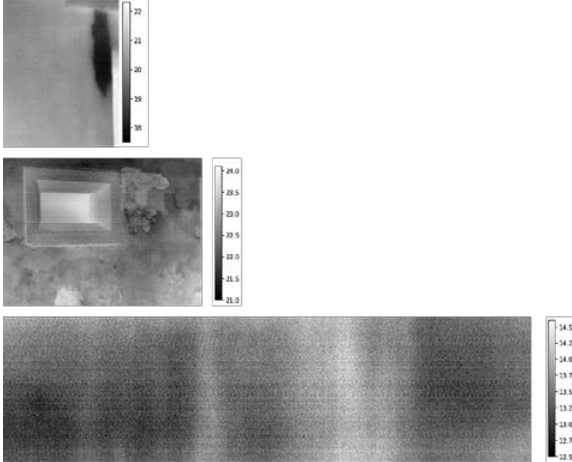
Figure 3. Input thermal images of the analysed case studies. From top to bottom: Test_1, Test_2 and Test_3 Figure 4 graphically shows the results of the moisture regions detection obtained with this methodology, representing on the right side of each result the corresponding real regions verified by an expert operator.